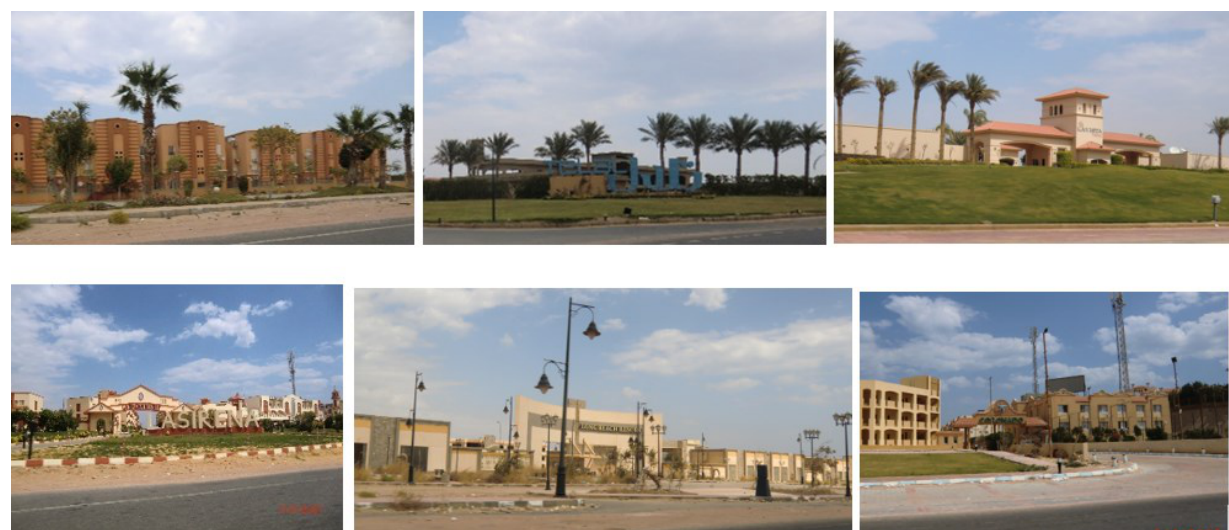
Figure 6. Post-Porto style (Source: